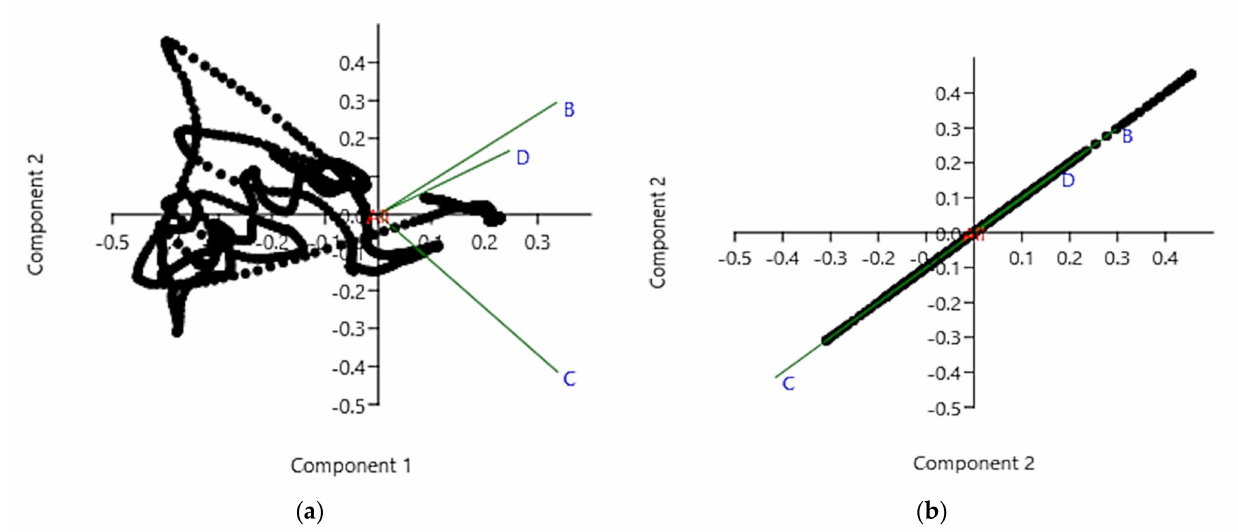
Figure 4. Principle component analysis (PCA) results represented as a score plot performed on the matrix collecting spectral data of UA (C), G4K (B) and UA-G4K (D). The red writing at the intersection of the axes (score = 0) is the group label (All). PC1 vs. PC2 ( a ); PC2 vs. PC2 ( b